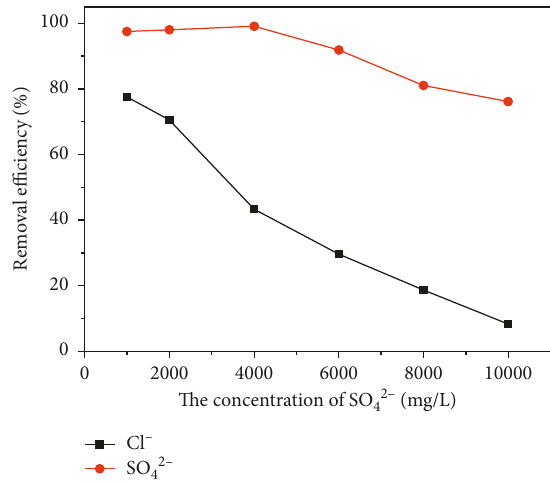
Figure 6: The effect of reaction time.